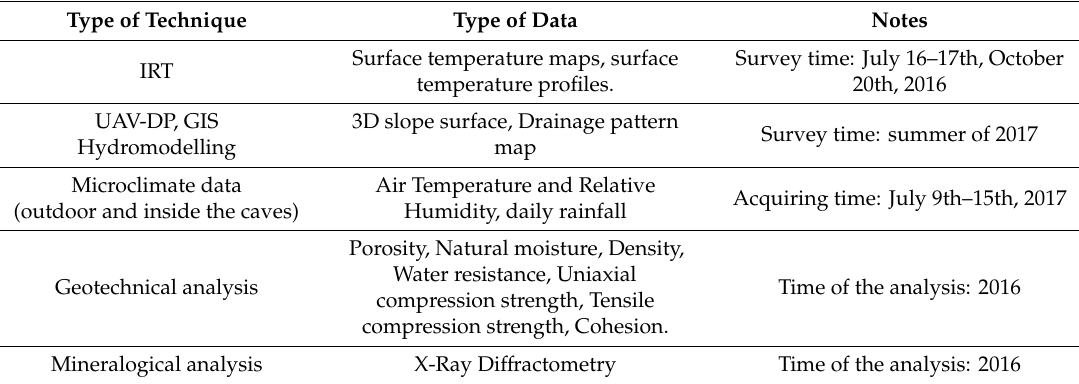
Table 1. Summary of the data adopted in the